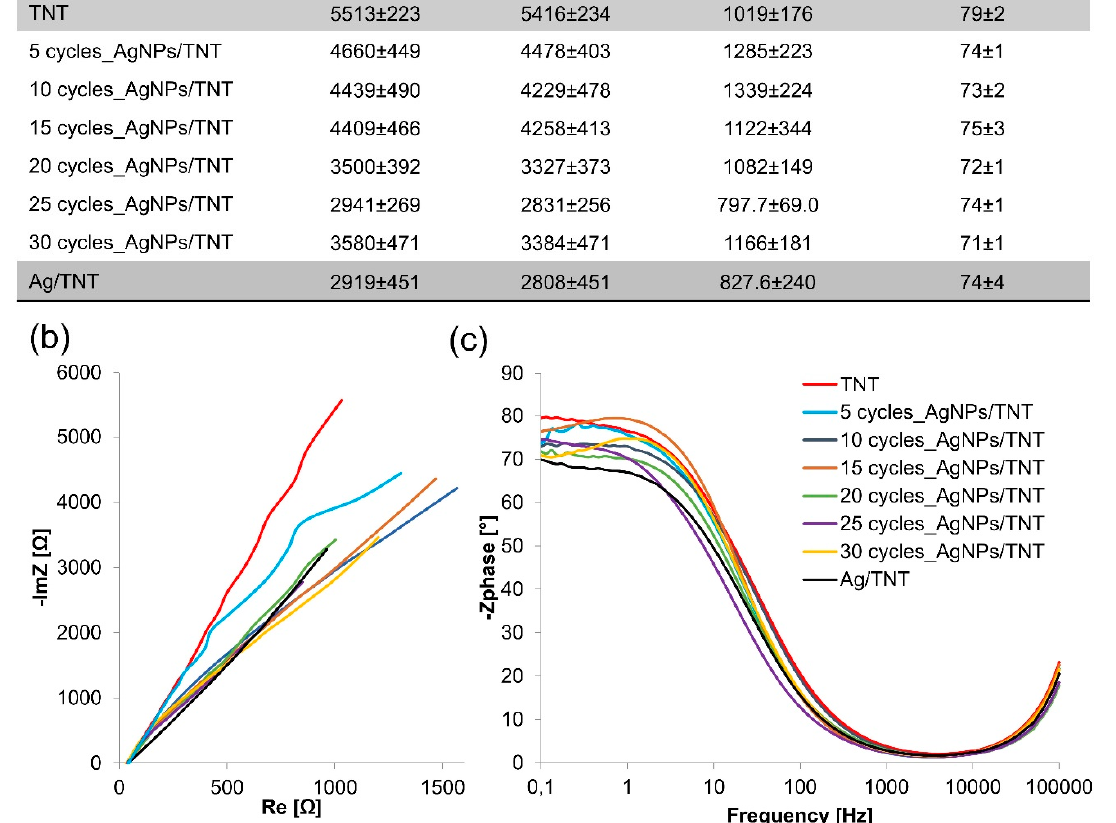
Figure 4. Summary of impedance parameters ( a ), Nyquist ( b ) and Bode ( c ) plots of AgNPs/TNT platforms differing in the number of cycles of silver nanoparticles deposition and reference layers: TNT and Ag/TNT. Spectra were recorded in the PBS solution (0.01 M, 10 ml, pH 7.4) over the frequency range 0.1–10 5 Hz with amplitude 10 mV.